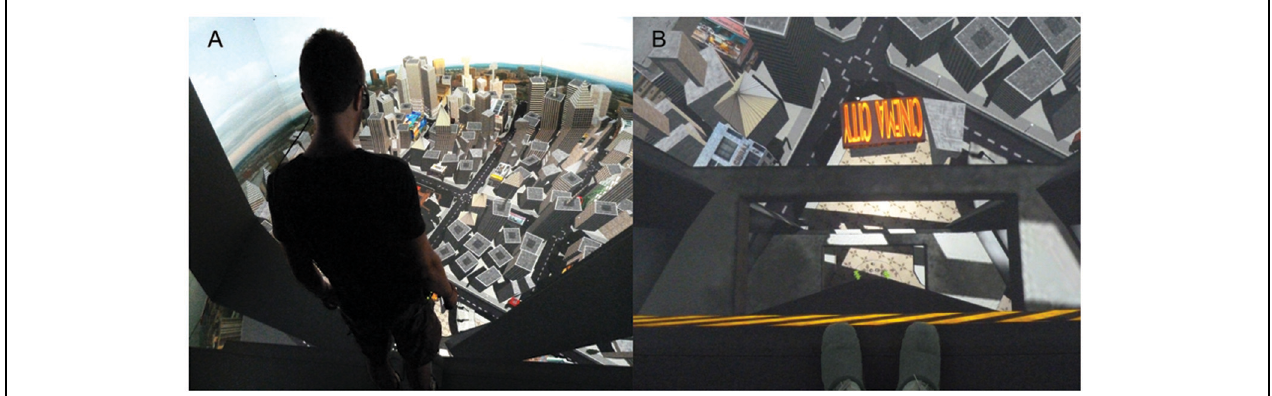
FIGURE 1 | (A) View of the city from the top floor. The participant is wearing the active-stereo glasses for stereoscopic vision. For the sake of clarity, the image has been displayed in mono; (B) First person perspective of the elevator ascending. Notice that the feet of the participant can be seen at the border of the virtual elevator, blending in with the virtual environment.